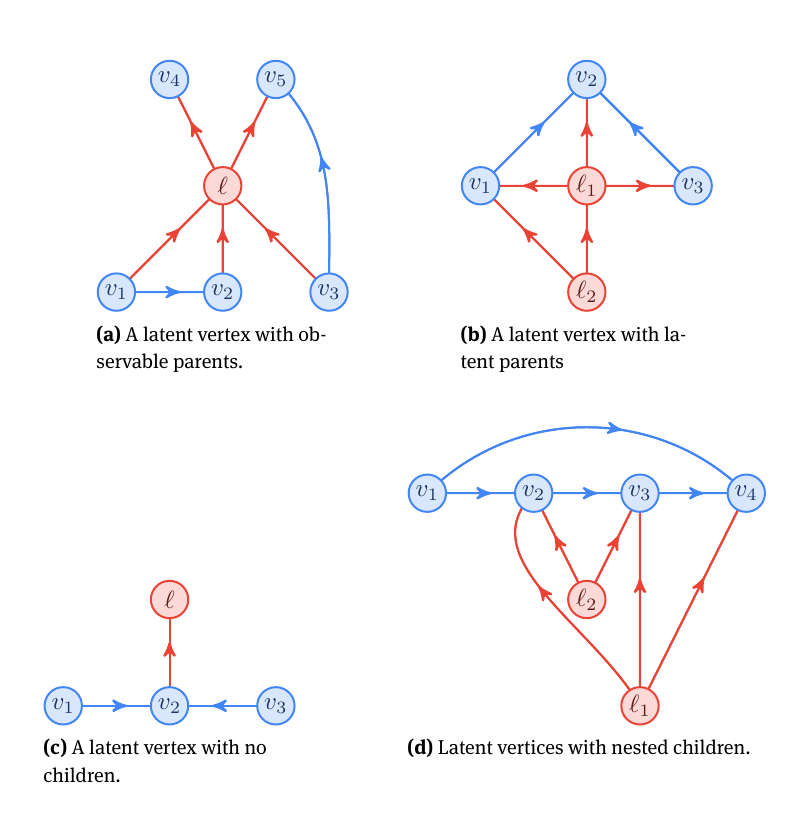
Figure 18: Examples of causal structures which are not exo-simplicial.